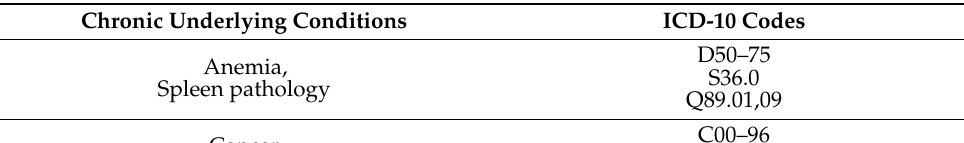
Table A1. Underlying medical conditions according to International Classification of